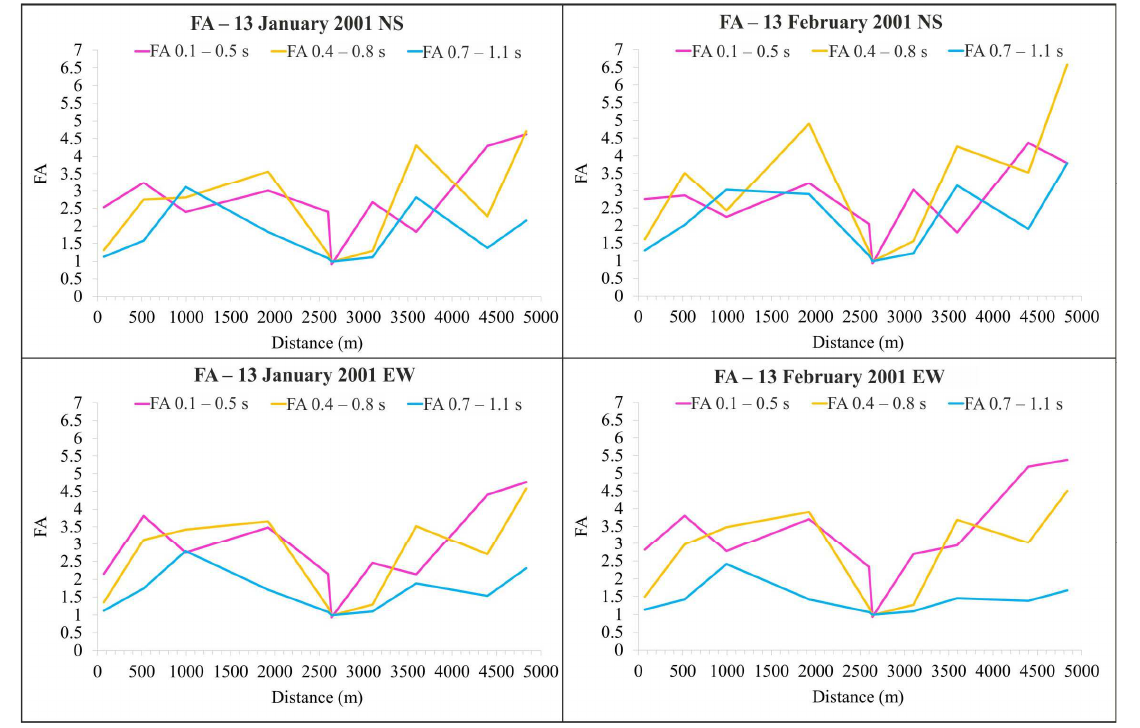
Figure 11. Calculated FA values along the section AA′, related to three period ranges (0.1–05 s, 0.4–0.8 s and 0.7–1.1 s), referring to the two components (NS, EW) of the two mainshocks on 13 January and 13 February 2001.